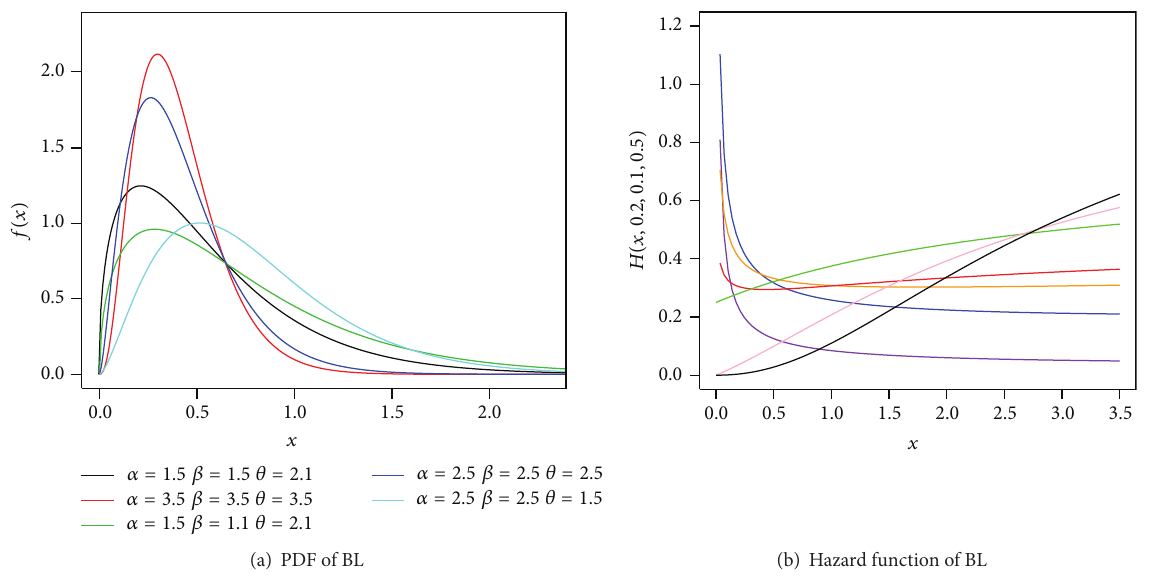
Figure 1: The PDF’s (a) and hazard’s function (b) of various BL